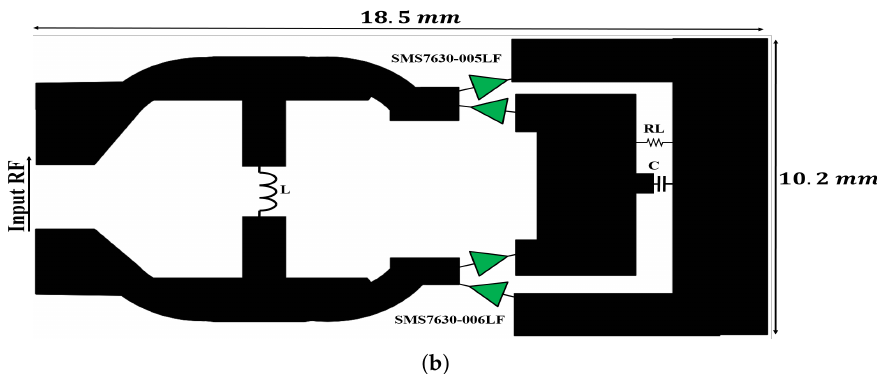
Figure 6. Topology of both the DR-A and DR-B rectifier circuits. ( a ) Layout of rectifier DR-A, ( b ) Layout of rectifier DR-B.